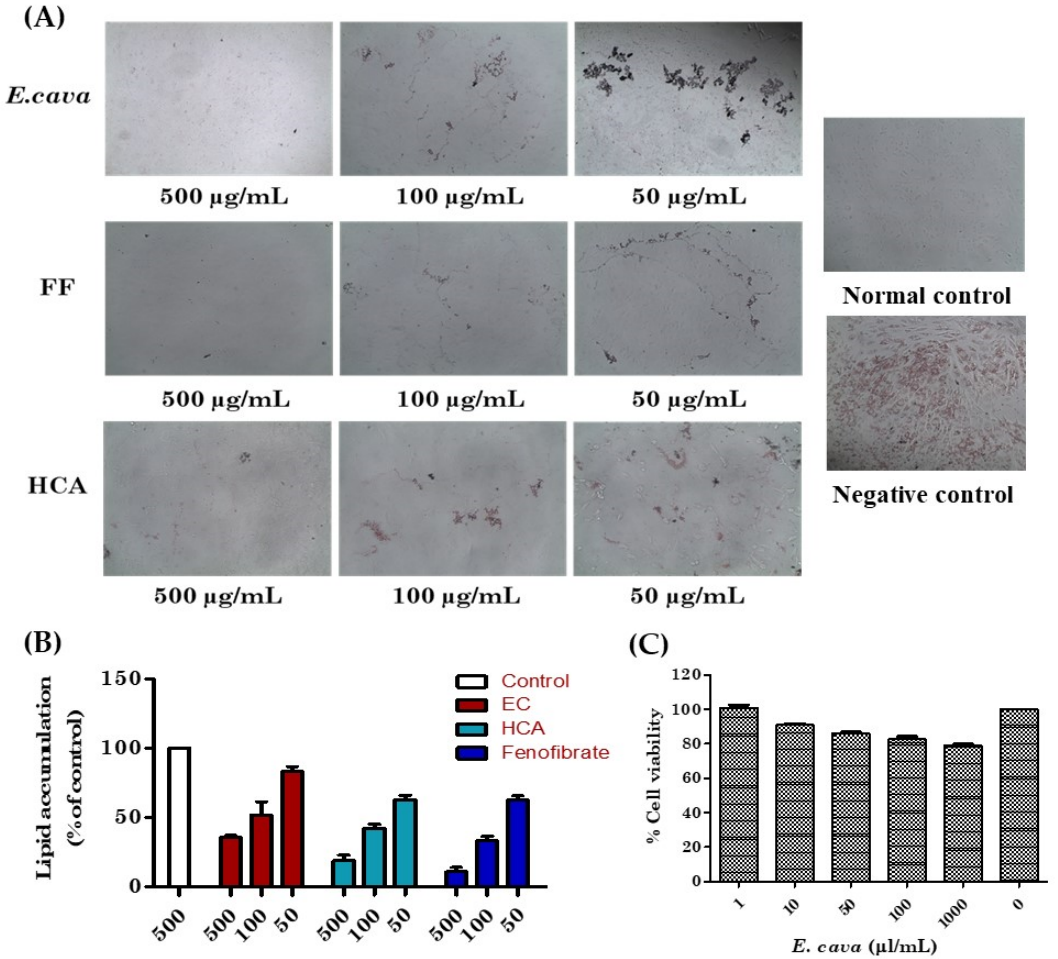
Figure 2. The effects of E. cava ethanol (70%) extract on the differentiation and adipogenesis of 3T3-L1 cells. ( A ) Intracellular lipids were stained with Oil Red O, ( B ) lipid accumulation percentage, and ( C ) cytotoxicity of E. cava extract in 3T3-L1 adipocytes.